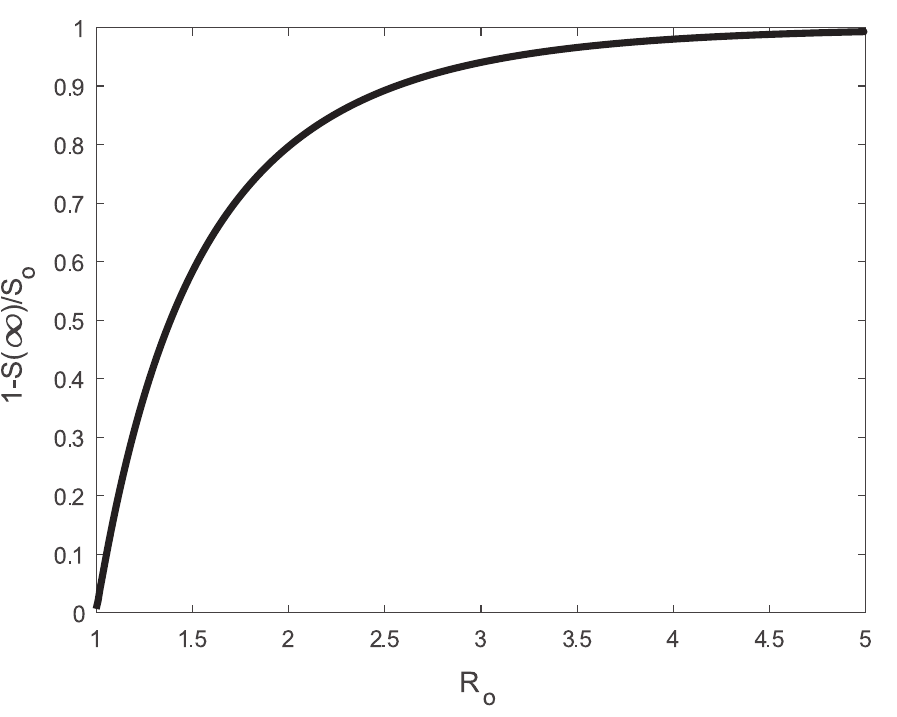
Fig 10. Relation between total infection fraction 1 − S ( 1 )/ S